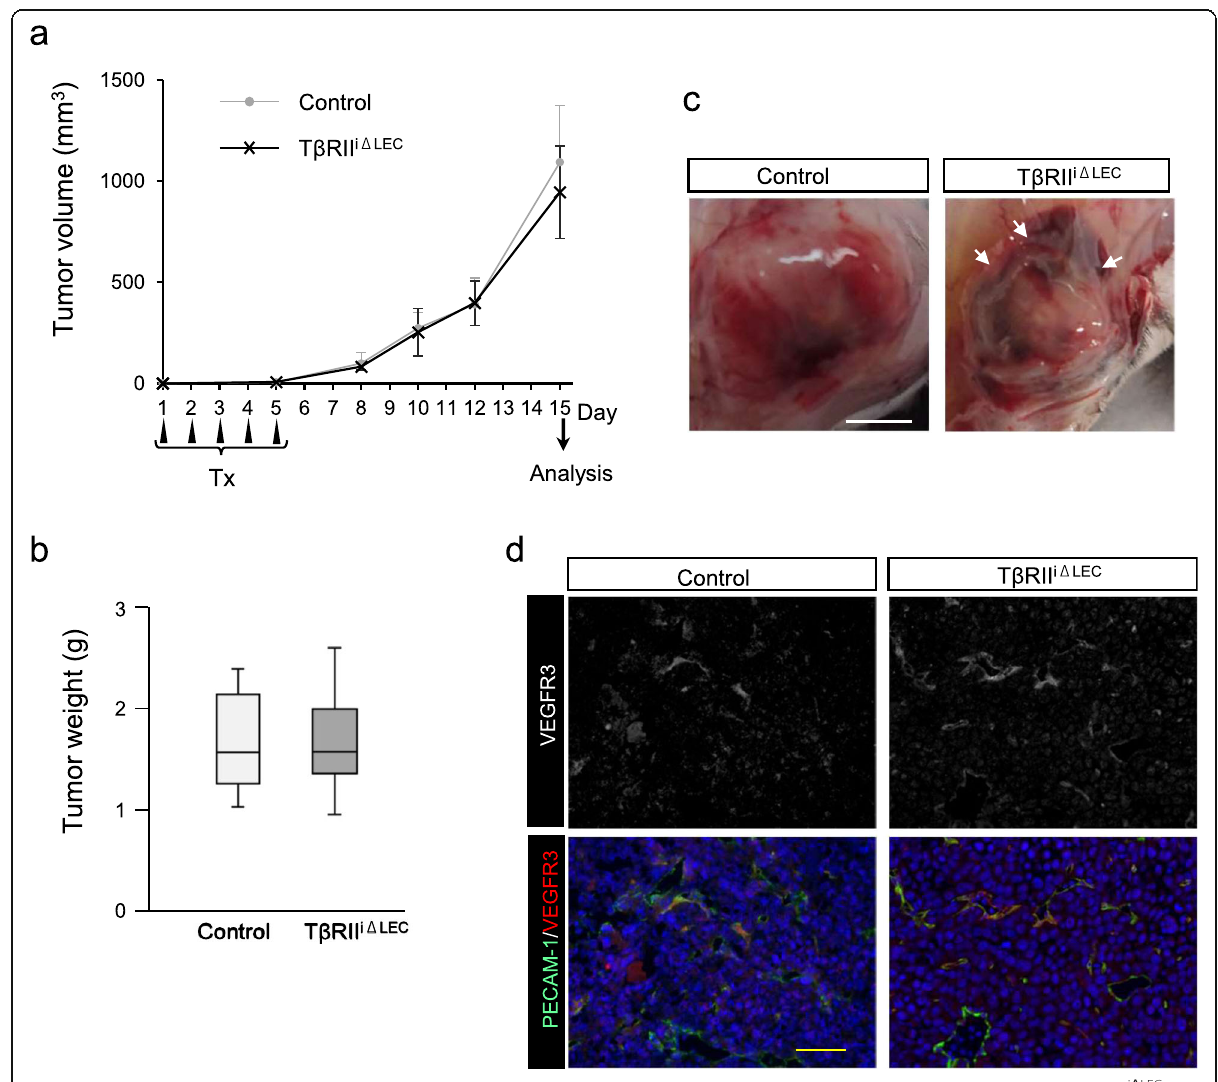
Fig. 4 LEC-specific T β RII deletion does not affect tumor growth. a LLC cells were subcutaneously transplanted into Tx-treated control or T β RII i Δ LEC mice. Tumor size was measured from above the skin at the indicated days. Tumor volumes were calculated using the formula: length × width × width × 0.5. The data presented are the means ± S.D. ( n = 6) b Tumor weight 15 days after LLC transplantation. ( n = 6) c Appearance of xenografted tumors transplanted into control or T β RII i Δ LEC mice 15 days after LLC transplantation. T β RII i Δ LEC mice had tissue fluid accumulation around tumor (arrows). Representative images are shown. Scale bar: 5 mm. d Immunohistostaining of the tumor sections with anti-PECAM-1 (green) and anti-VEGFR3 (red) antibodies. Sections were counterstained with DAPI (nucleus, blue). Scale bar: 50 μ